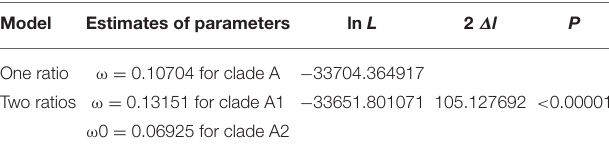
TABLE 1 | Statistics for the detection of selection in angiosperm ACOs using branch specific models of PAML.